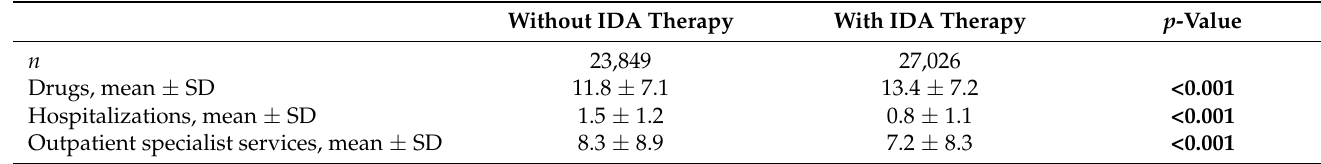
Table 3. Healthcare resource use in ND-CKD-IDA alive patients treated or not with IDA therapy, during the follow-up, post PSM (data are given as mean ± SD per patient). Significant p -values are highlighted in